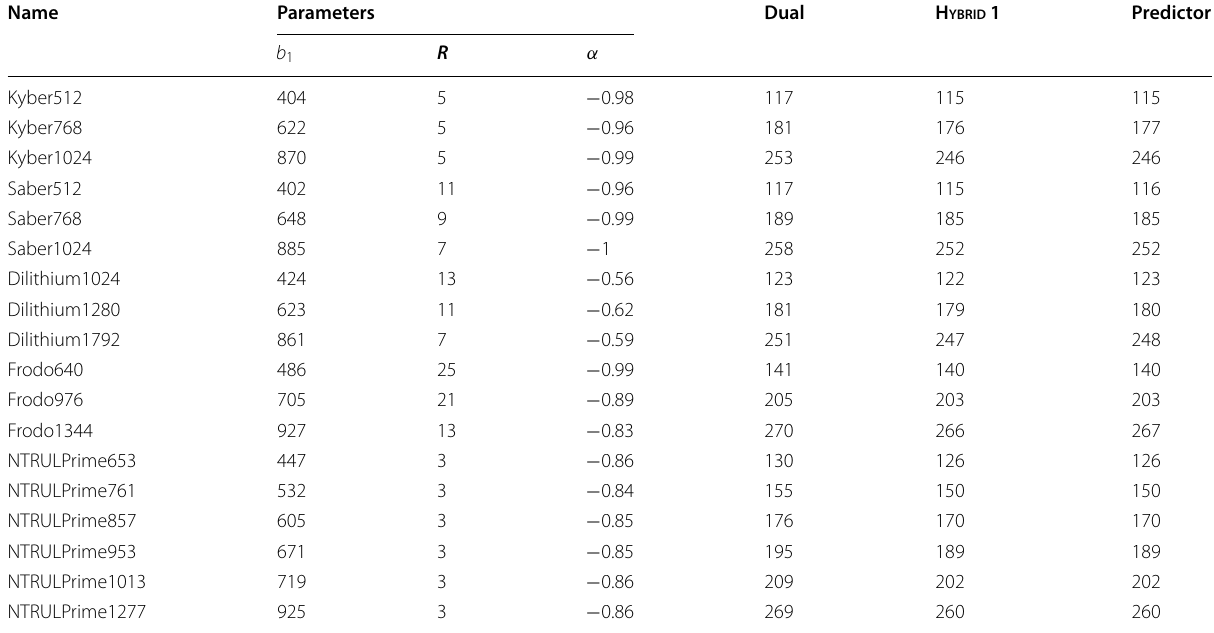
Table 10 Comparison of H ybrid 1 and the Predictor